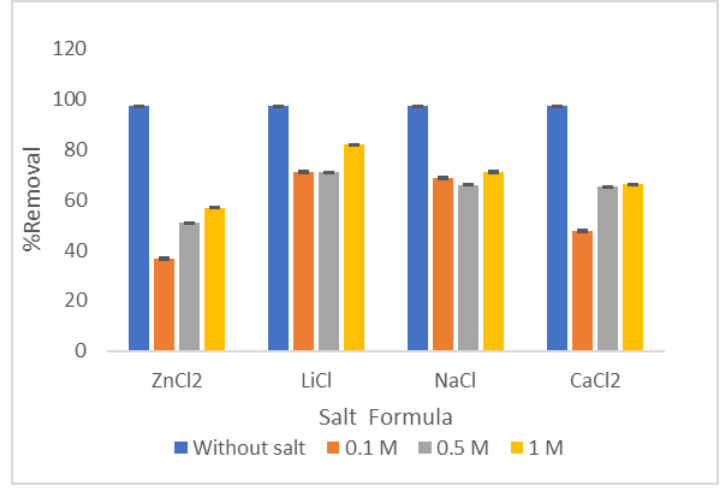
Figure 15. Effect of presence of different salts on % removal of CV using LCF.